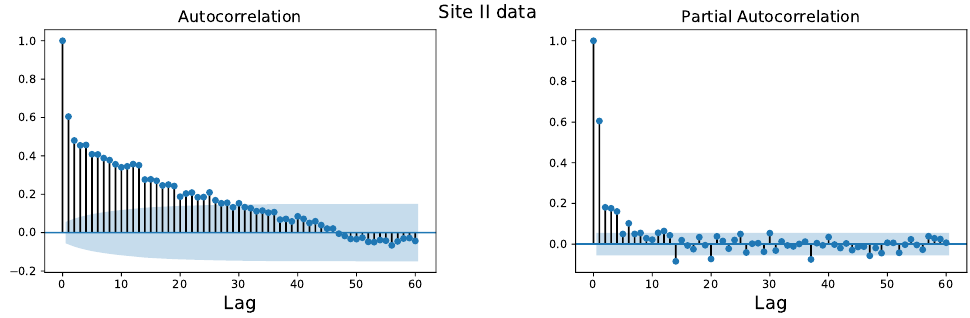
Figure 6. Autocorrelation ( left ) and partial autocorrelation ( right ) for Site II.